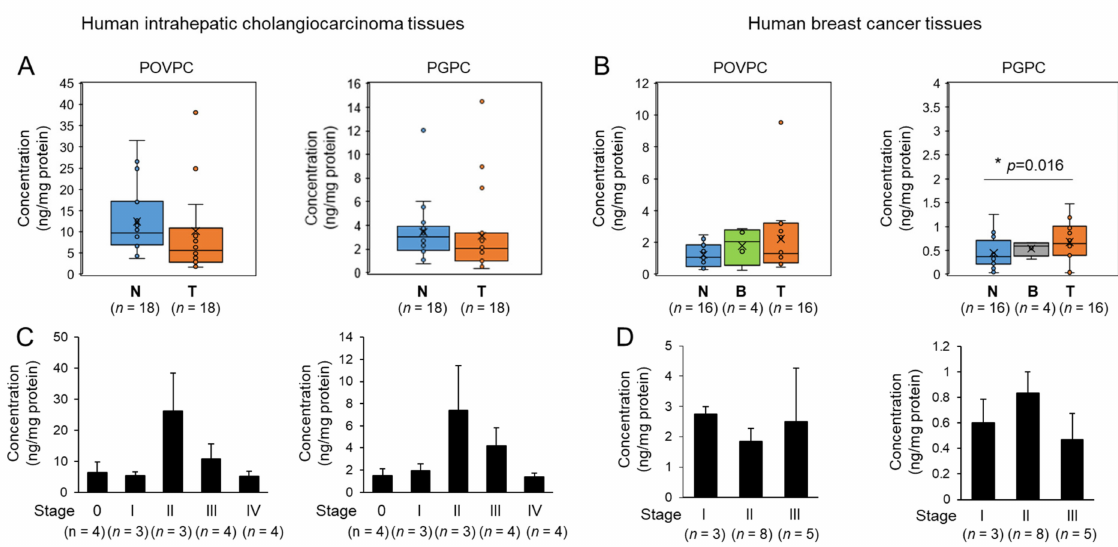
Figure 6. The levels of 1-palmitoyl-2-glutaroyl- sn -glycero-phosphocholine (PGPC) and POVPC in patient-derived tumor tissues and nontumor tissues. ( A , B ) POVPC and PGPC quantities were determined by LC-MS/MS analysis in ( A ) human intrahepatic cholangiocarcinoma tissues (T) and adjacent nontumor tissues (N); ( B ) human breast tumor tissues (T), benign tumor tissues (B), and adjacent nontumor tissues (N). The bar represents means ± SEM. Dots represent individual values. ( C , D ) The levels of POVPC and PGPC were determined by LC-MS/MS analysis in different stages of tumors. The bar represents means ±